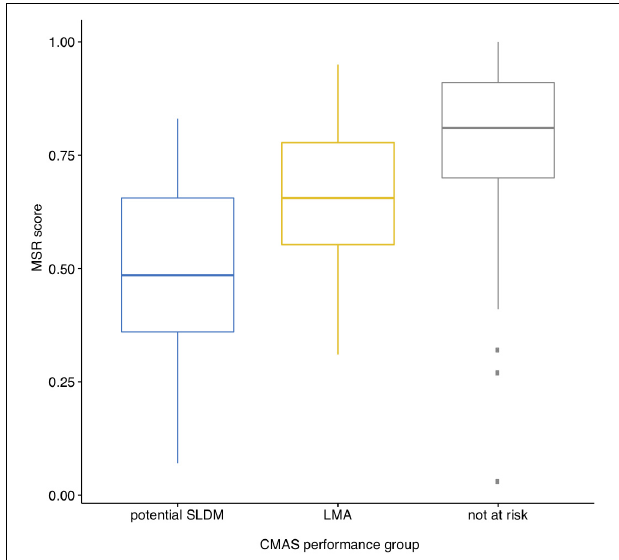
FIGURE 5 | Boxplots for MSR score by CMAS performance group.